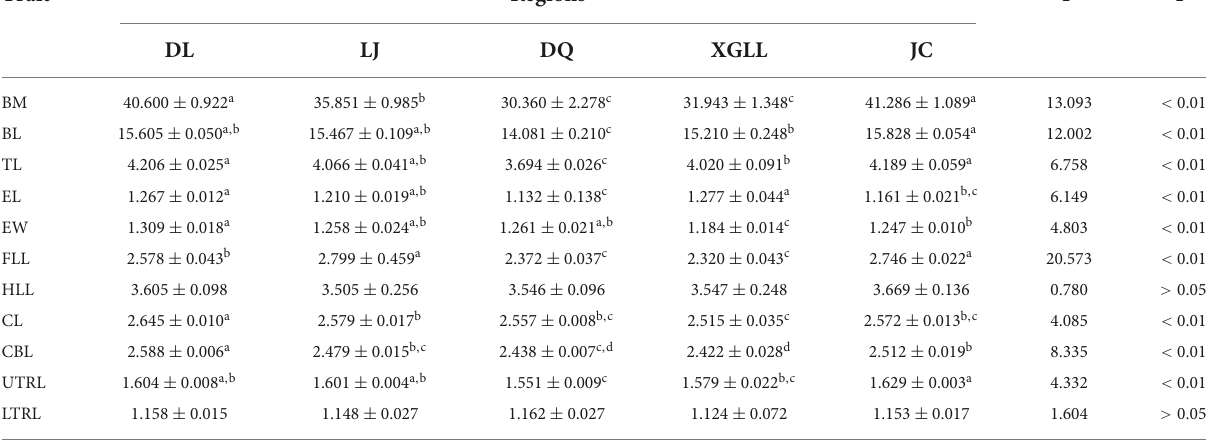
TABLE 2 Comparison of morphological indicators in Eothenomys miletus. Trait